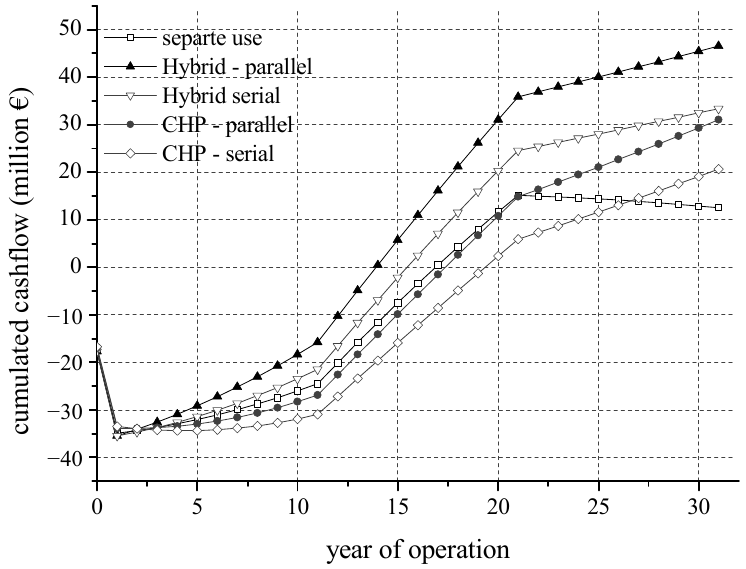
Figure 11. Cumulated cashflow for the considered power plant concepts.